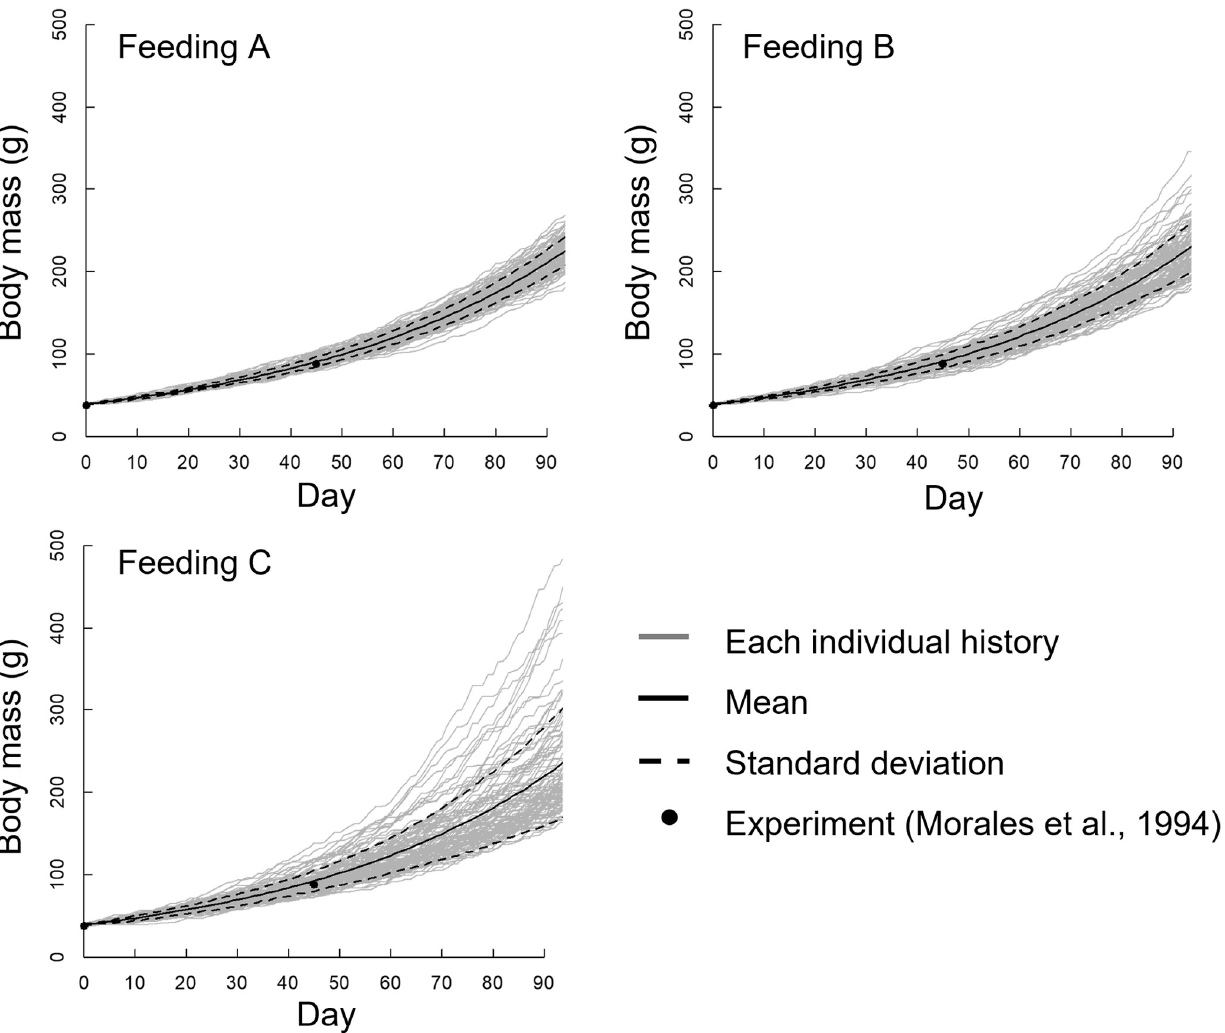
Fig 8. Growth history of the body mass of all 100 individuals using the three feeding methods, without performing randomization every day. The mean and standard deviation of the body mass and previous experimental results [19] are also indicated.